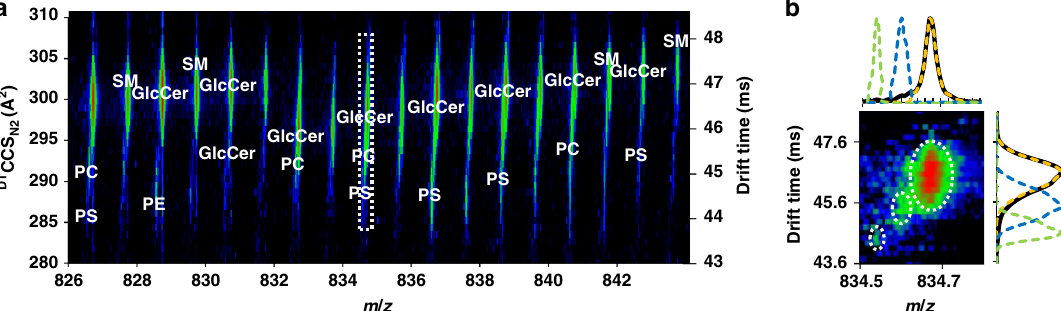
Fig. 5 Spectrum of a mixture of PE, PS, PC, SM, and GlcCer lipids. Data was obtained in positive ionization mode. a A 2D IM-MS spectrum for a mixture of lipid extracts, with individual lipid classes annotated. b Selected region demonstrated multiple lipid features residing within a narrow mass and mobility range. Dotted lines represent extracted mobility and mass spectra for circled features, which include GlcCer (orange), PC (blue), and PS (green)